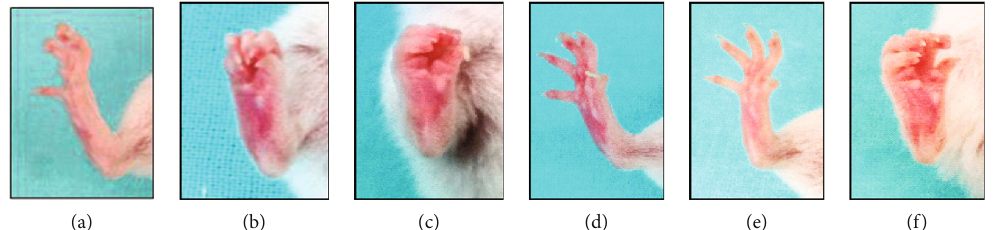
Figure 3: The e ff ect of long-term injection of CII and LPS on the right hind paw. The images of right hind paws of selected animals taken after six times of injections of PBS (a), CII alone (b), a mixture of CII and KO3 LPS (c), YeO3 S LPS (d), YeO3 Ra LPS (e), and YeO3 Rd1 LPS (f).